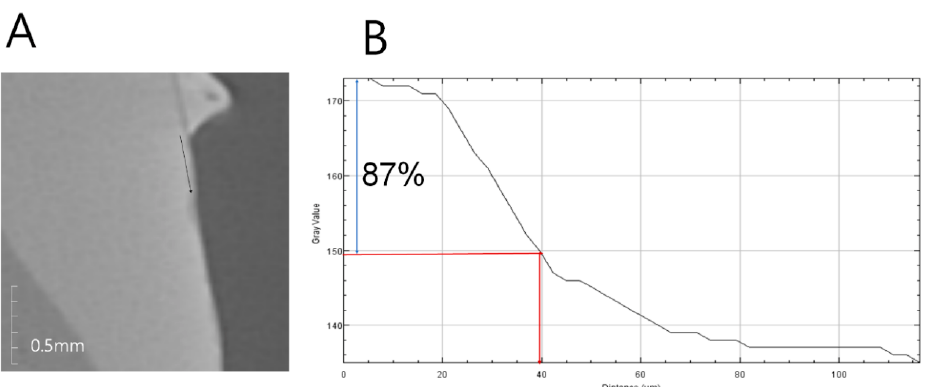
Figure 1. Anti-demineralization length analysis method. ( A ) Micro-computed tomography (CT) slice of ROI (region of interest) at the center of the lesion perpendicular to the enamel surface. The starting point was the end of the adhesive. Black line: the line of ROI from a reference point on the enamel surface; ( B ) Histogram in ImageJ. Blue arrow: up to 87% level of gray value from the reference point; red arrow: the distance at the 87% gray value from the reference point.